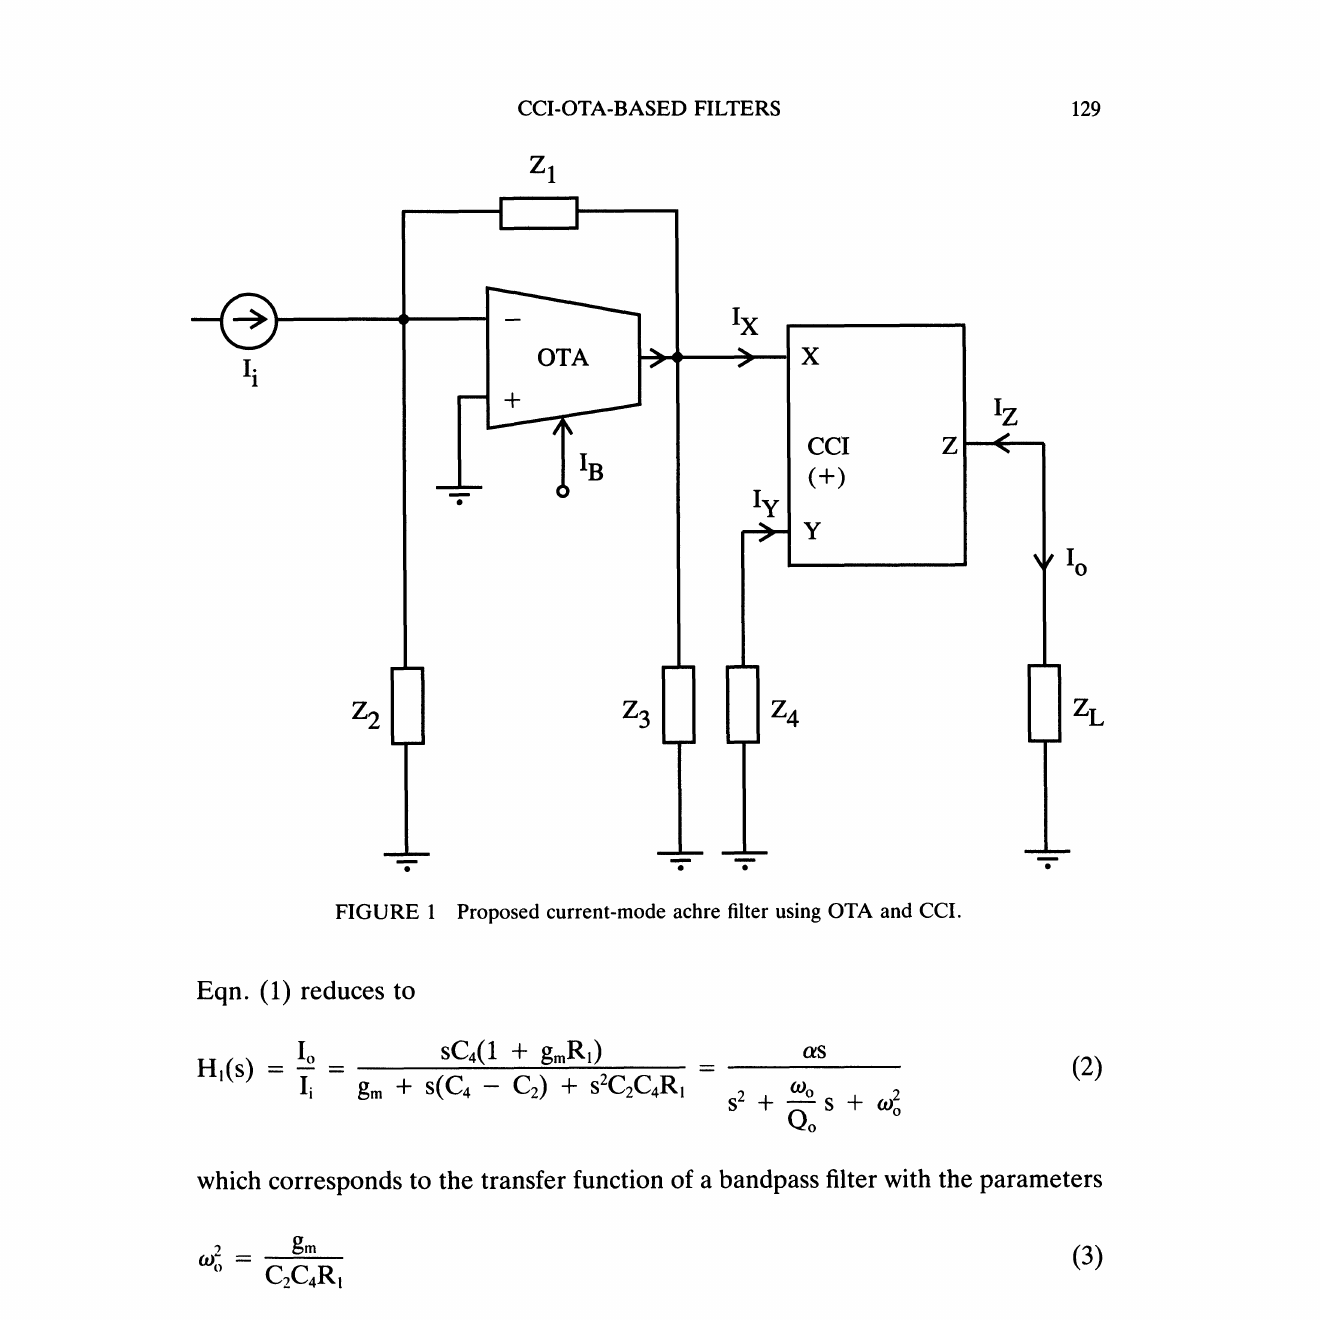
FIGURE Proposed current-mode achre filter using OTA and